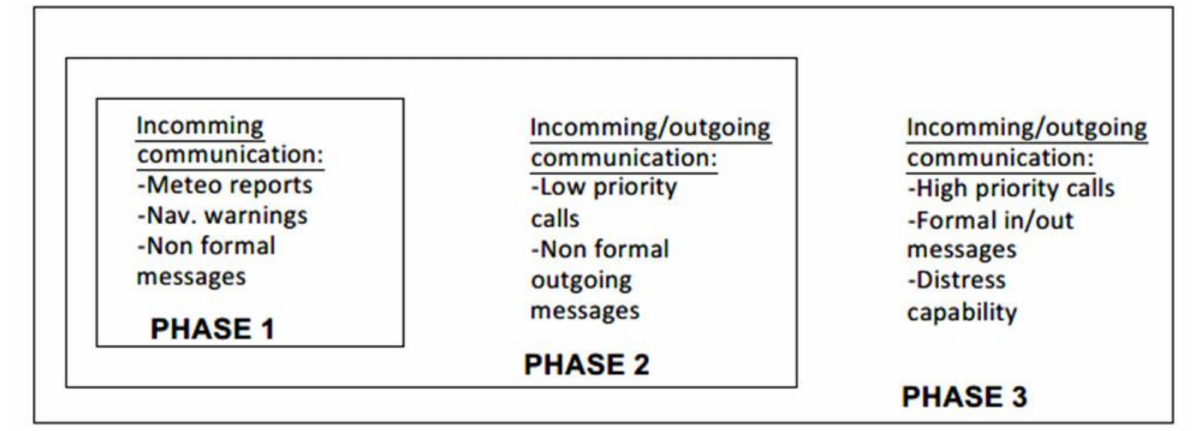
Figure 8. Development phases of SDR for the needs of maritime